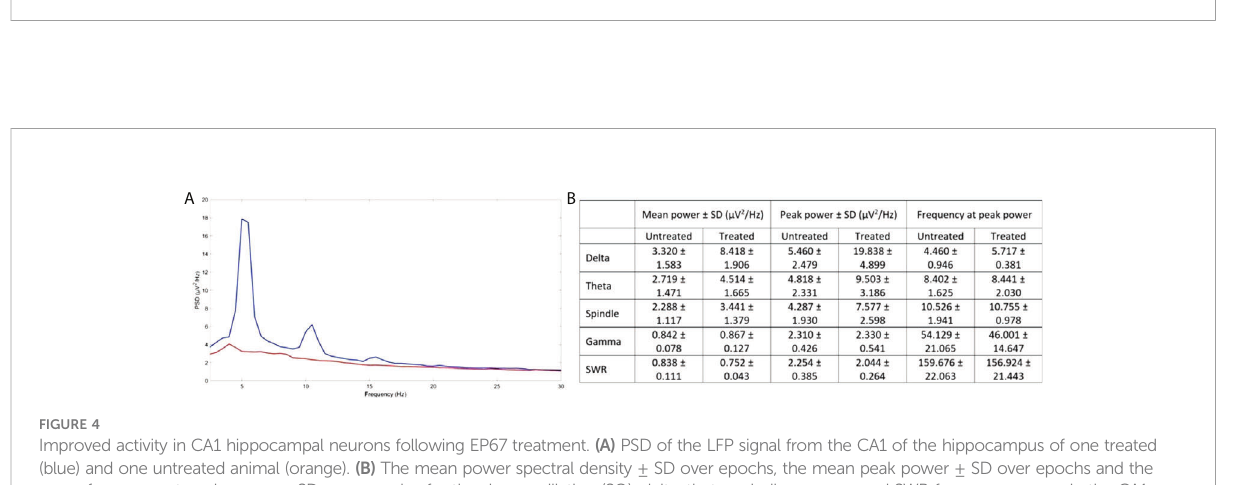
FIGURE 4 Improved activity in CA1 hippocampal neurons following EP67 treatment. (A) PSD of the LFP signal from the CA1 of the hippocampus of one treated (blue) and one untreated animal (orange). (B) The mean power spectral density ± SD over epochs, the mean peak power ± SD over epochs and the mean frequency at peak power ± SD over epochs, for the slow oscillation (SO), delta, theta, spindle, gamma, and SWR frequency ranges in the CA1 region of the hippocampus of a treated and an untreated mouse.